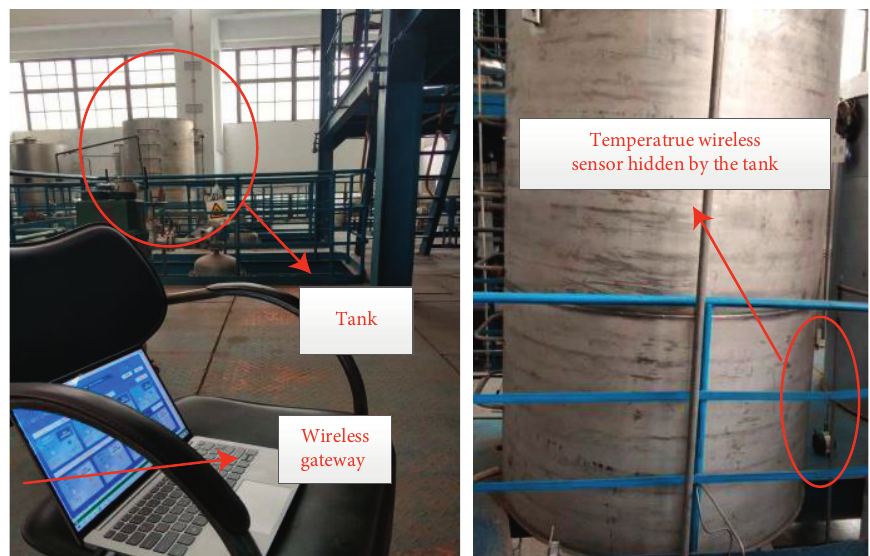
Figure 21: Wireless temperature sensor arrangement at a special location on the second floor of the platform.